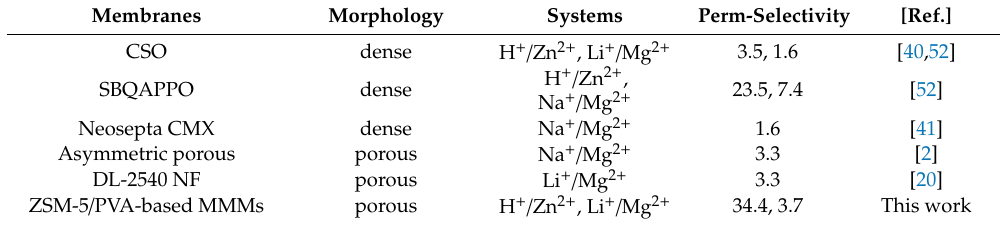
Table 1. Characteristics’ properties of recently reported membranes and ZSM-5 / PVA-based